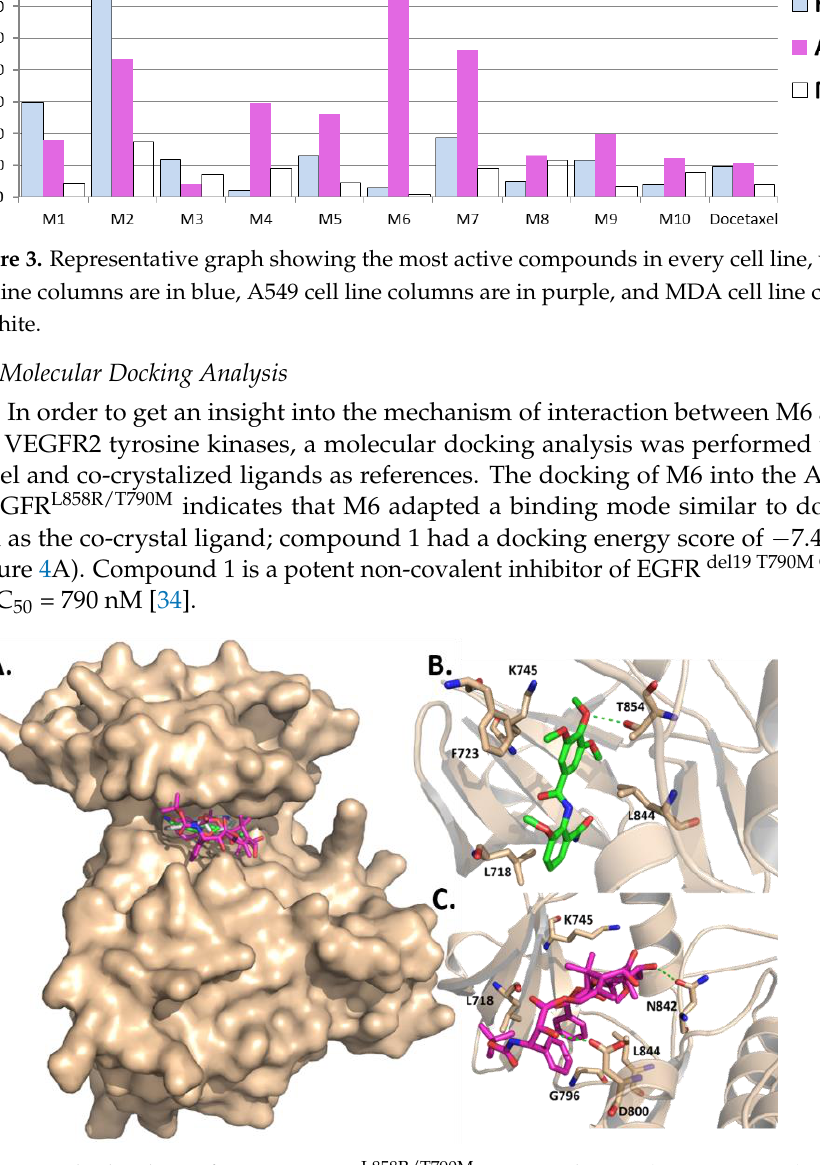
Figure 3. Representative graph showing the most active compounds in every cell line, where Hela cell line columns are in blue, A549 cell line columns are in purple, and MDA cell line columns are in white.